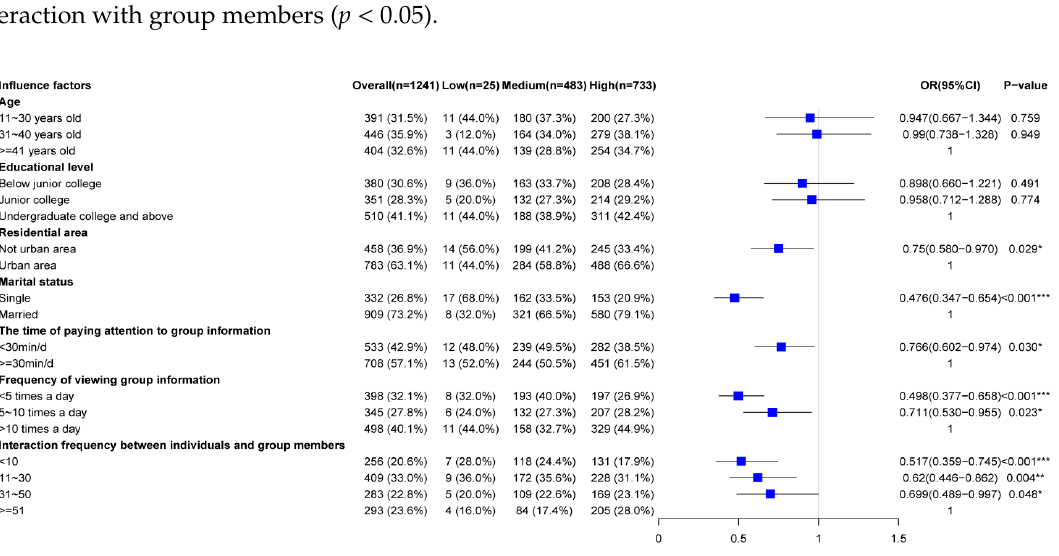
Figure 4. The forestplot of Ordinal logistic regression analysis results for influence factors Figure 4. and self-efficacy. and self-e ffi